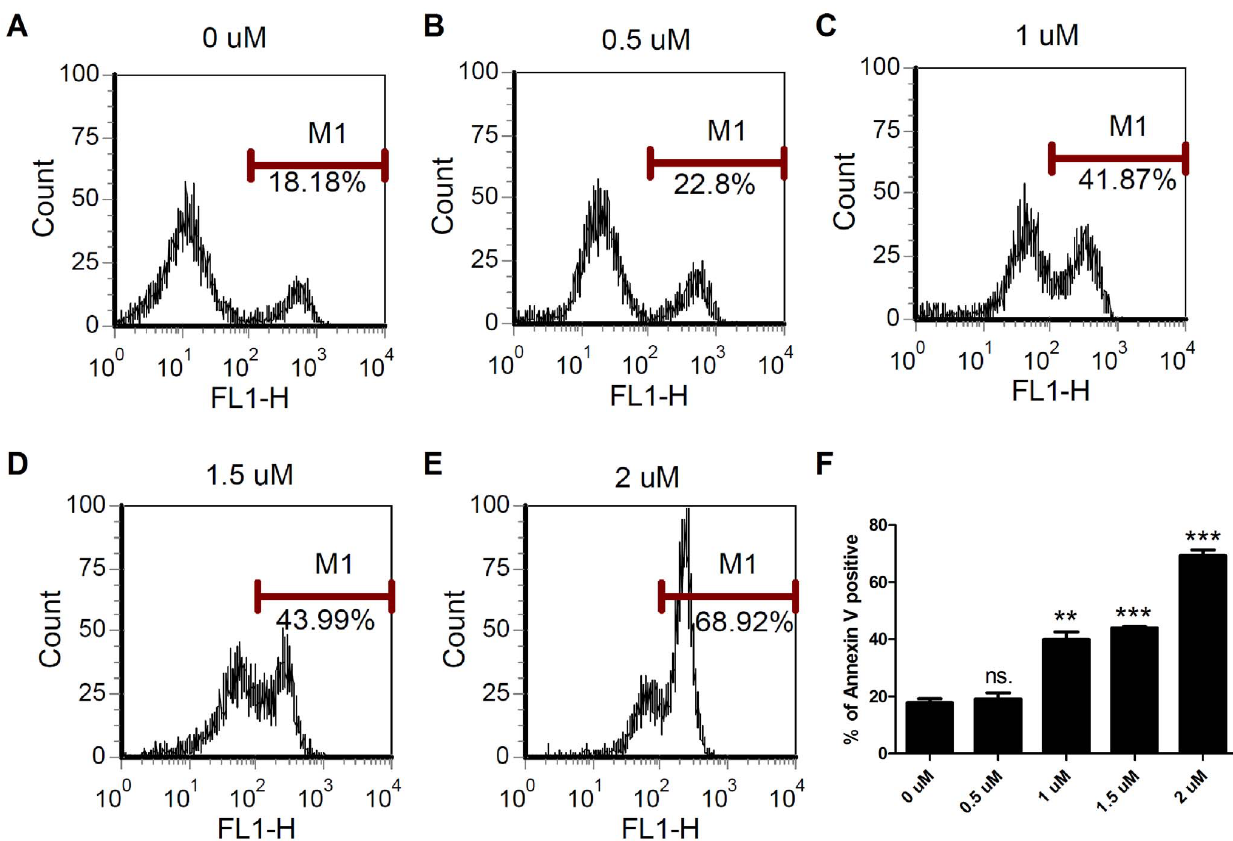
Figure 2. NSC745885 induces early apoptosis in SAS cells. SAS cells were treated with (A to E) indicated doses of NSC745885 for 24 hours. Harvested cells were stained with FITC-conjugated annexin V and analyzed by flow cytometry. (F) The percentages of annexin V positive cells under NSC745885 treatment were compared with vehicle controls (0 m M) (n = 3; **, P , 0.01; ***, P , 0.001; ns., non-significant).